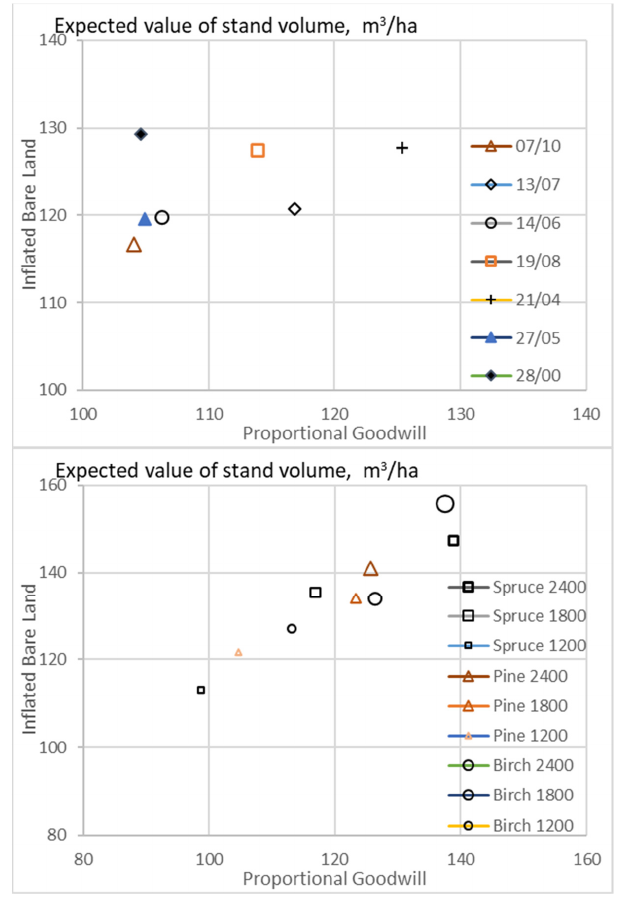
Figure 11. The expected value of commercial stand volume within the two manifestations of inflated capitalization, without any thinning restrictions, for the two datasets. Any deviation from the procedures corresponding to the maximum capital return rate induces a deficiency in the capital return rate. Annual monetary deficiency per hec- tare can be gained by multiplying the deficiency in percentage per annum by the current